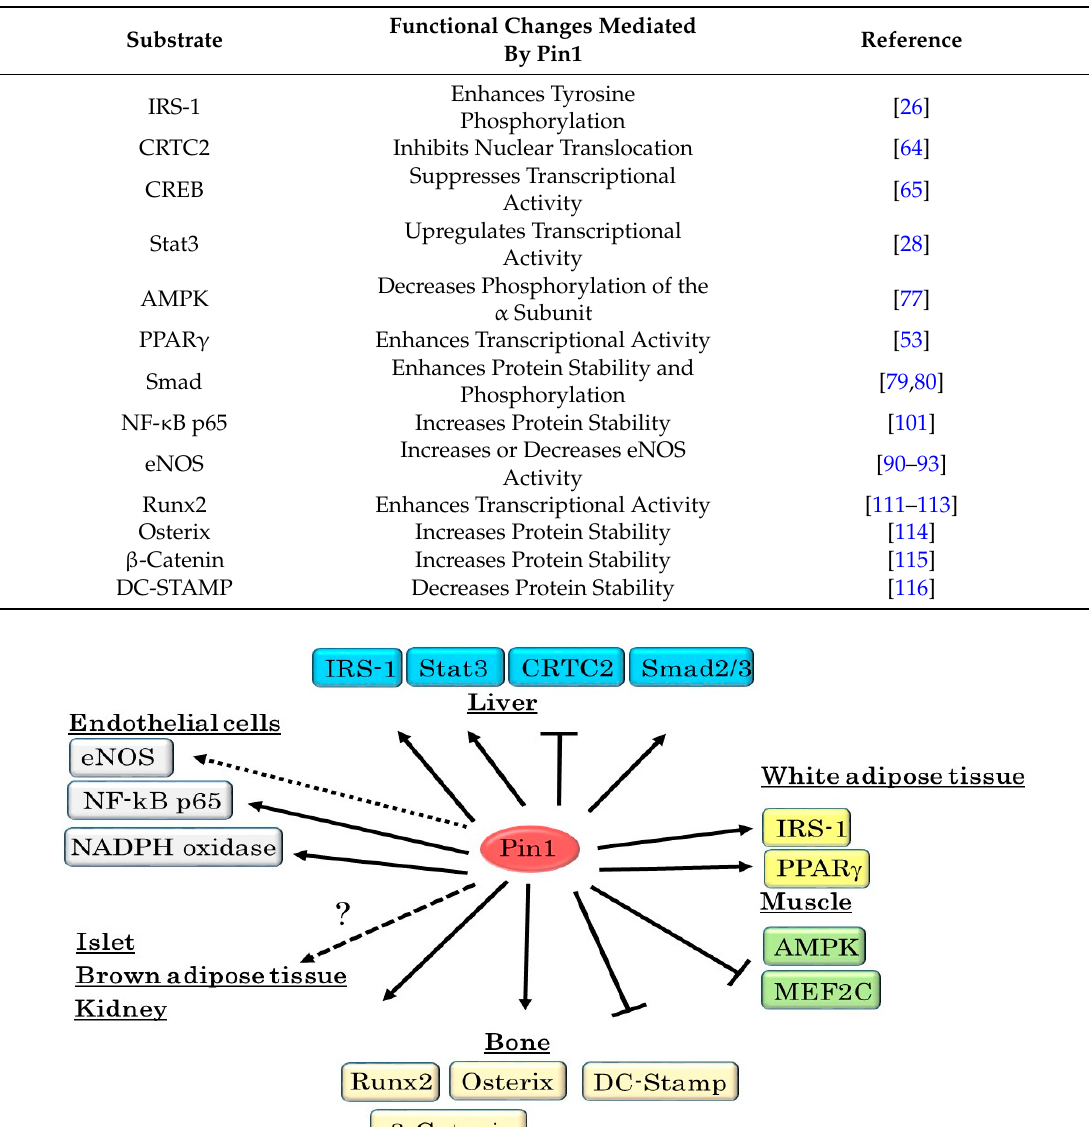
Table 1. List of Pin1 substrates in metabolic regulation.